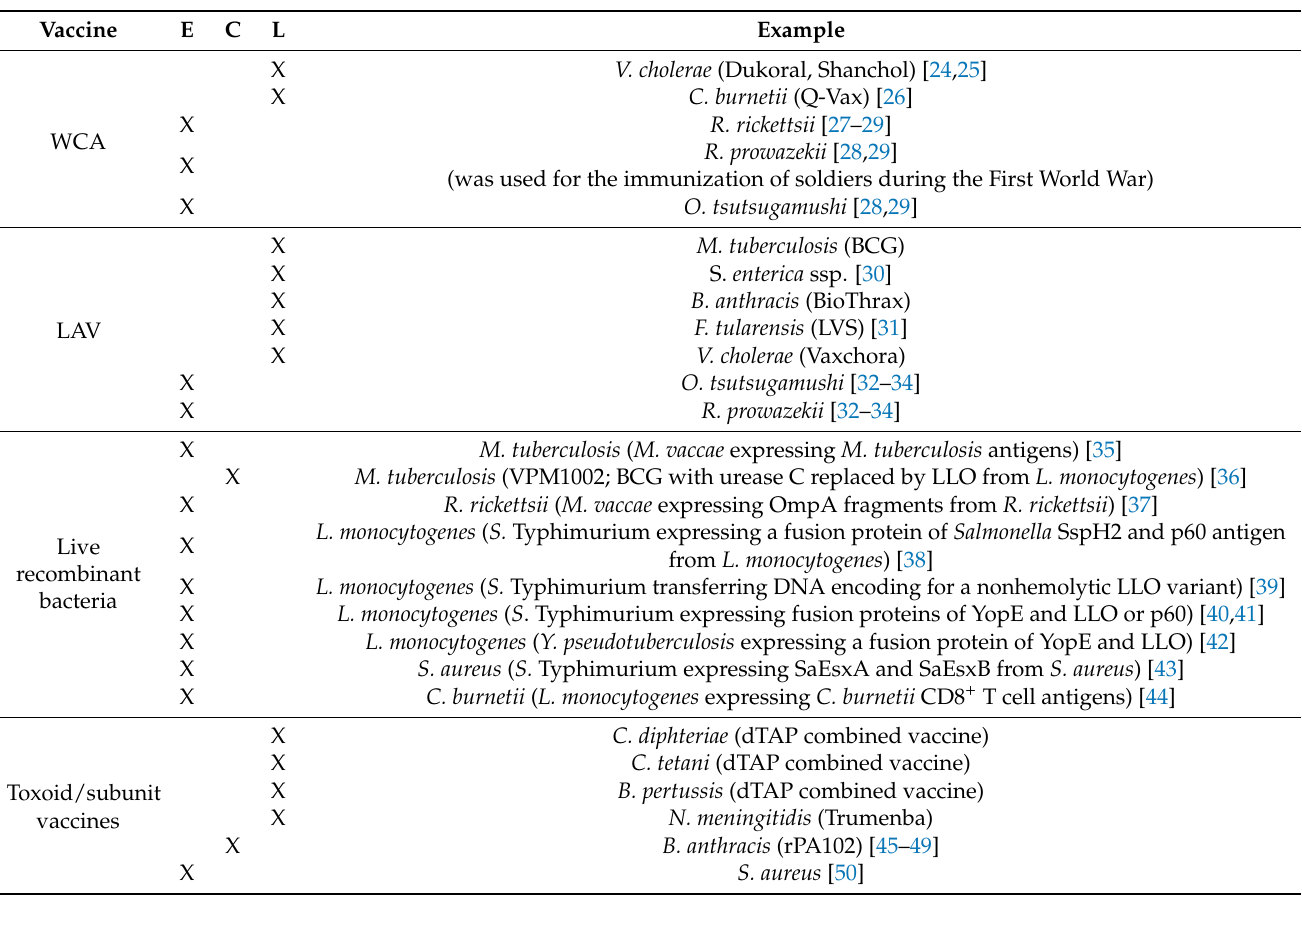
Table 1. Applied and experimental vaccines against bacterial